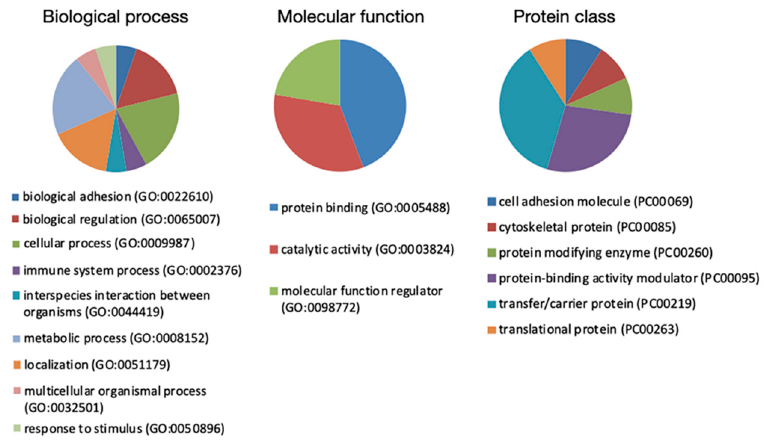
Figure 6. PANTHER classification of identified proteins in the EC serum according to their biologi- cal process, molecular function, and protein class. process, molecular function, and protein